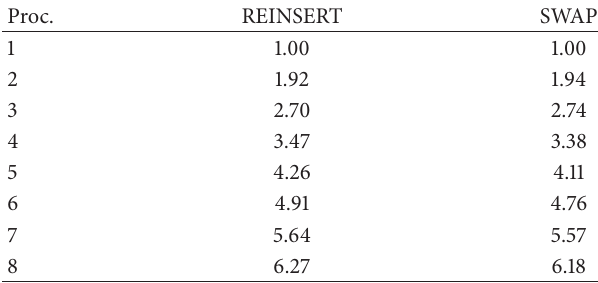
Table 10: Speed-up: 𝑁 (𝑅) with balanced start. Proc.